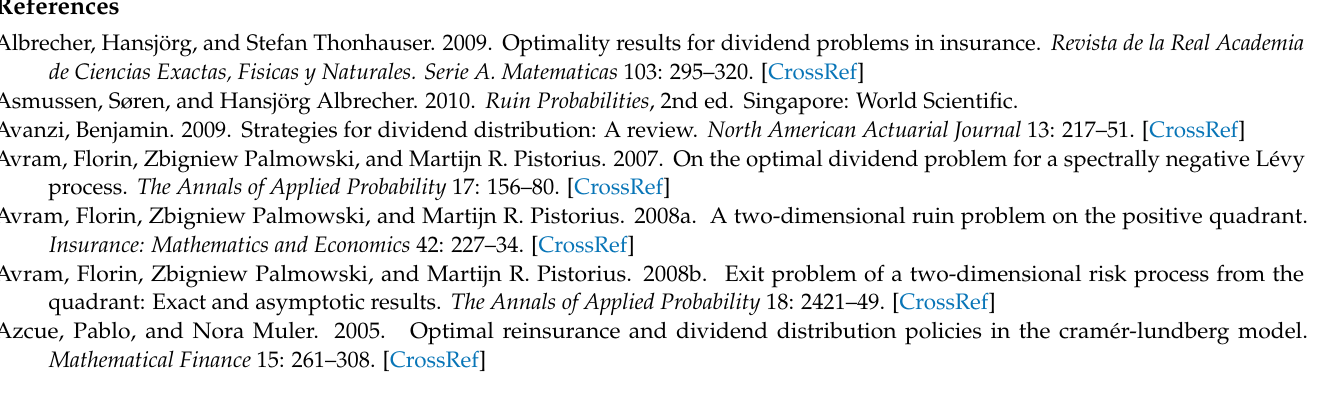
Figure 3. Approximated value functions V L ∗ 1 , V L ∗ 2 with the optimal barriers x b with respect to different initial values x 0 from several